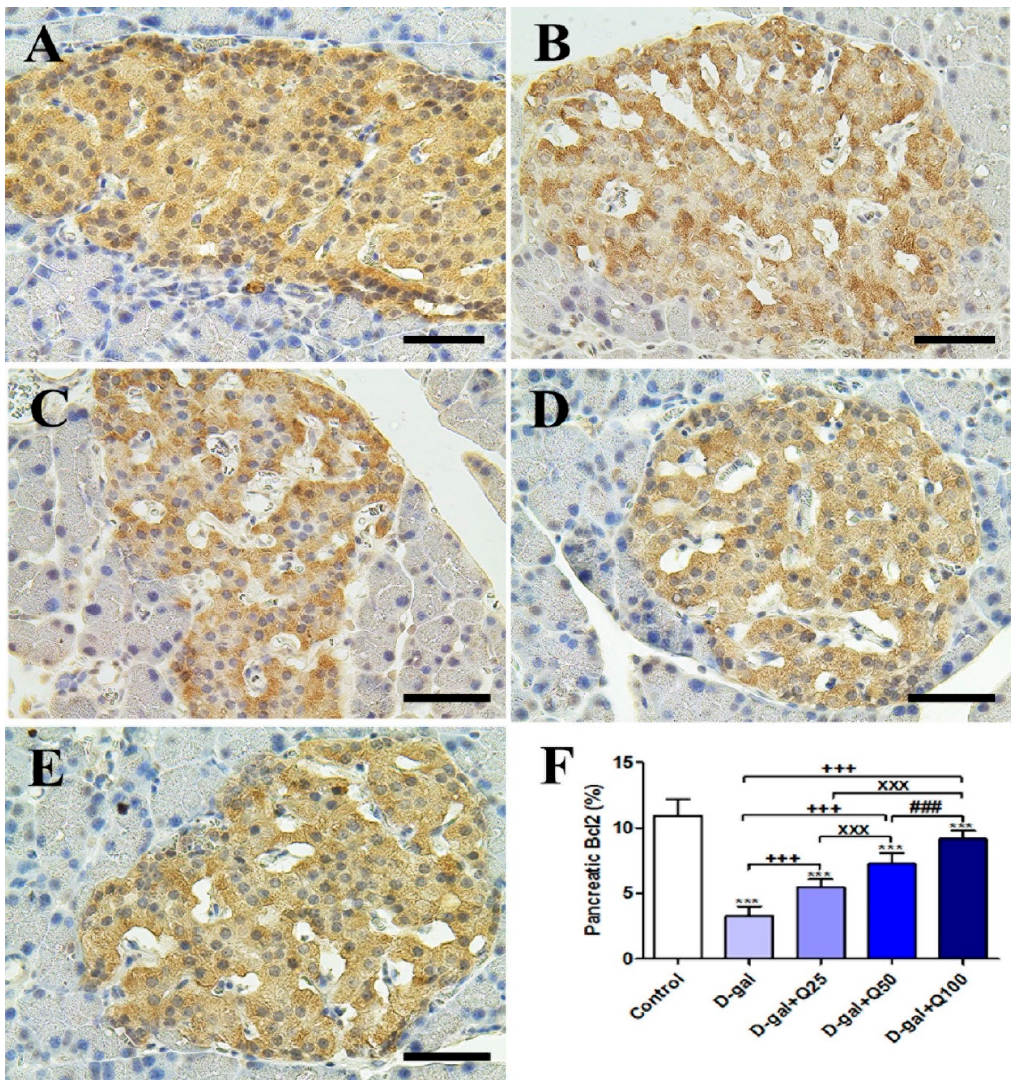
Figure 2. Immunohistochemical staining of rats’ pancreas with B-cell lymphoma 2 (Bcl2). ( A ) Negative control group. ( B ) D-gal group. ( C ) D-gal+Q25 group. ( D ) D-gal+Q50 group. ( E ) D-gal+Q100 group. ( F ) Quantification of Bcl2 in the pancreatic islets of Langerhans in different groups. Scale bar = 50 µm . Data were analyzed with one-way ANOVA followed by Tukey’s multiple comparison test. *** p < 0.001 vs control. +++ p < 0.001 vs D-gal. xxx p < 0.001 vs D-gal+Q25. ### p < 0.001 vs D-gal+Q50. Error bars represent mean ± SD.